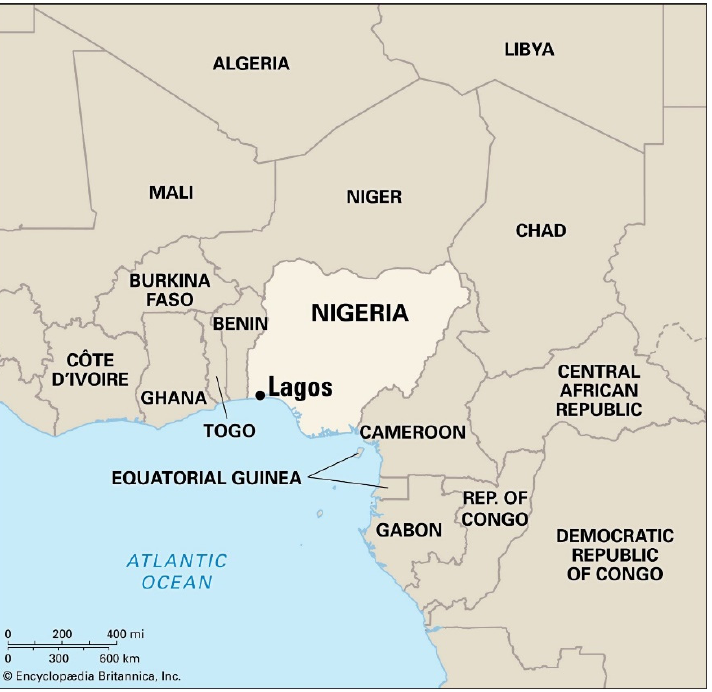
Figure 3. Map of Nigeria and location of Lagos State. Source: Britannica [50] (p. 1).